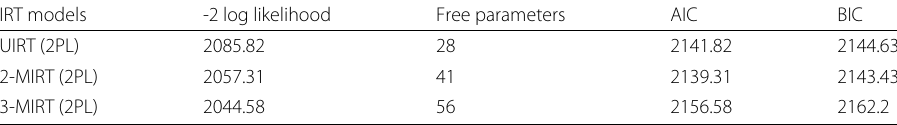
Table 9 Goodness of fit statistics for UIRT (2PL) and MIRT (2PL) models in test-one IRT models -2 log